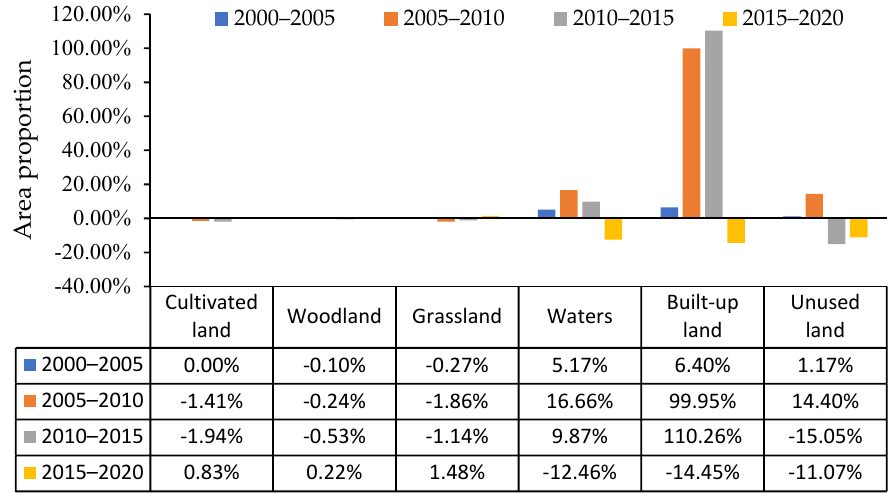
Figure 3. Area percentage of land use types in Shiyan from 2000 to 2020.